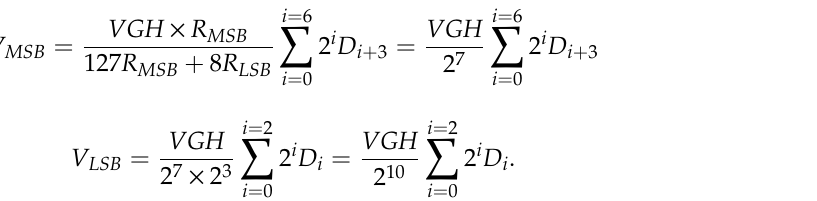
Figure 3. The schematic diagram of our proposed area-efficient 10-bit DAC with buffer-reusing method: ( a ) the 1st stage sub-DAC and ( b ) the 2nd stage sub-DAC.